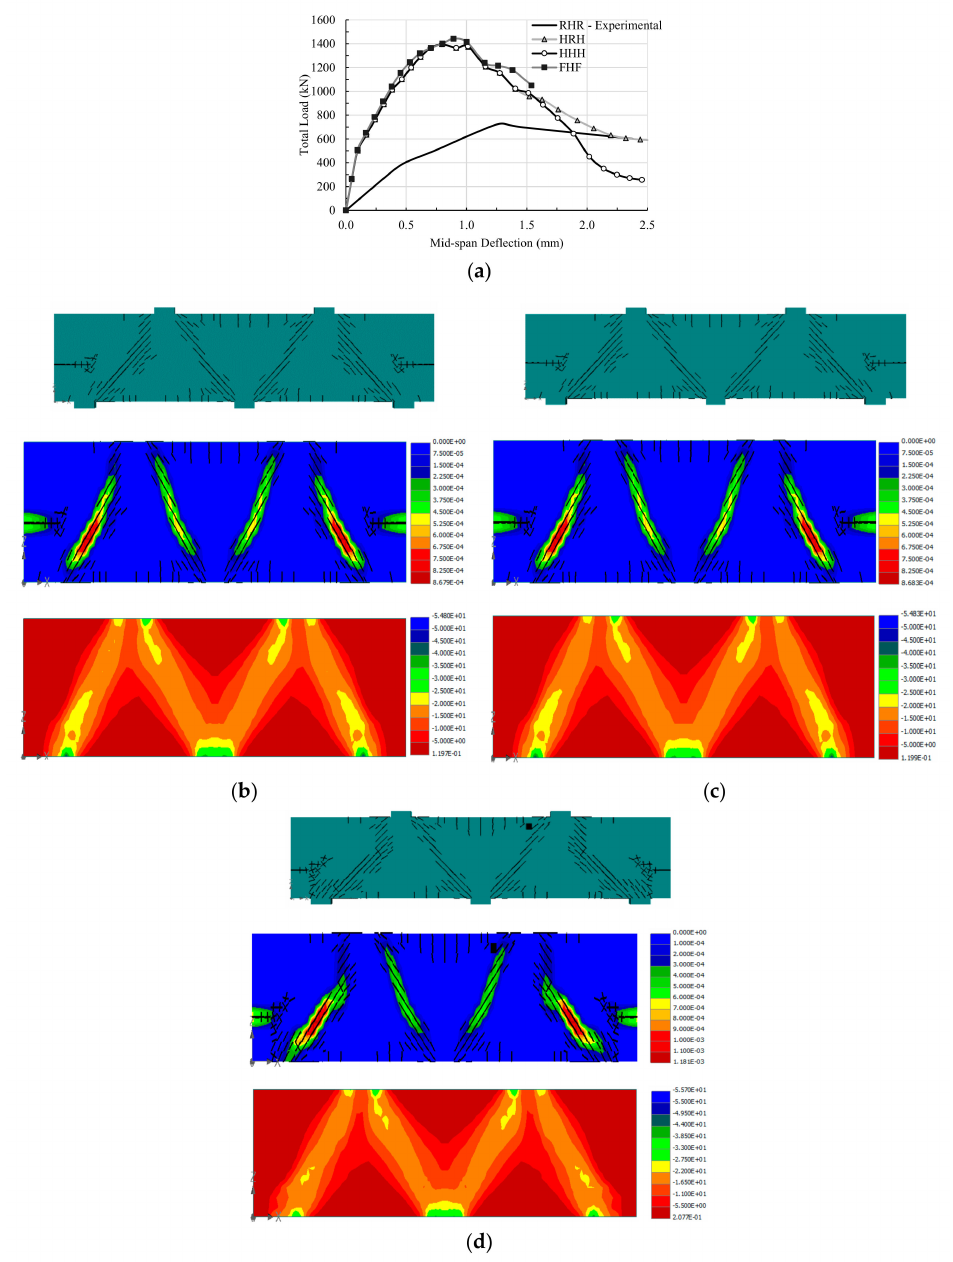
Figure 9. Responses of specimen L10-40 with three di ff erent sets of support conditions: ( a ) Experimental (RHR,[9])andnumericalLoad-deflectioncurvesforspecimenL10-40; ( b )crackpattern( top ), crackwidth ( middle ), and stress distribution (MPa) ( bottom )—HRH support conditions; ( c ) crack pattern ( top ), crack width ( middle ), and stress distribution (MPa) (bottom)—HHH support conditions; ( d ) crack pattern ( top ), crack width ( middle ), and stress distribution (MPa) ( bottom )—FHF support